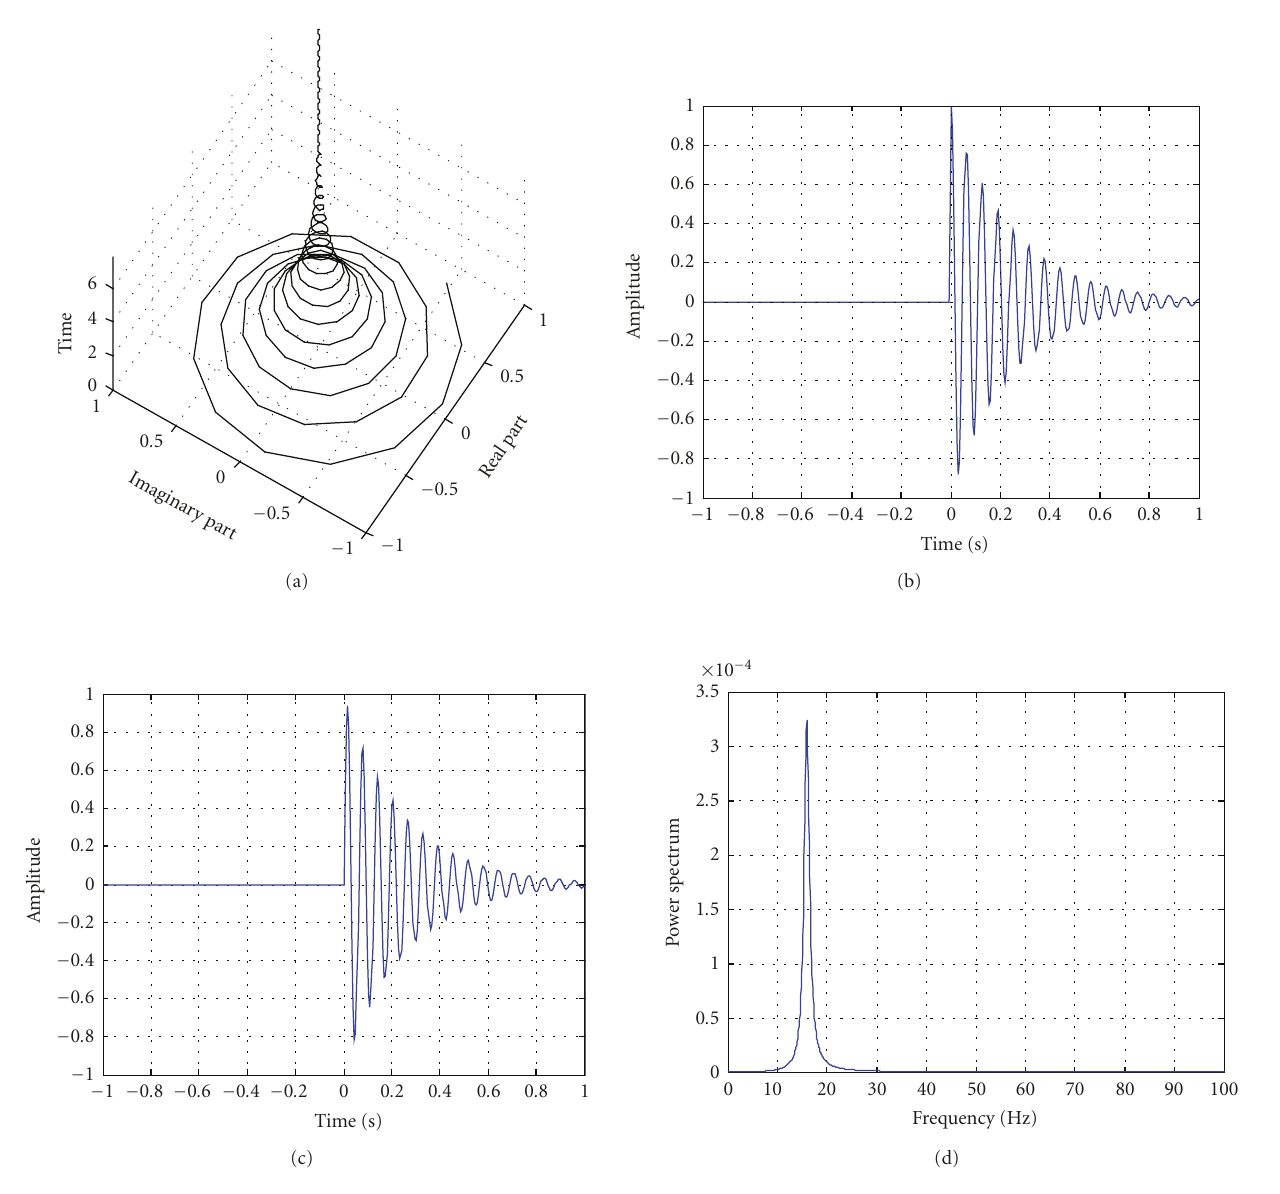
Figure 3: (a) The Laplace wavelet, (b) the real part, (c) the imaginary part, and (d) its spectrum.